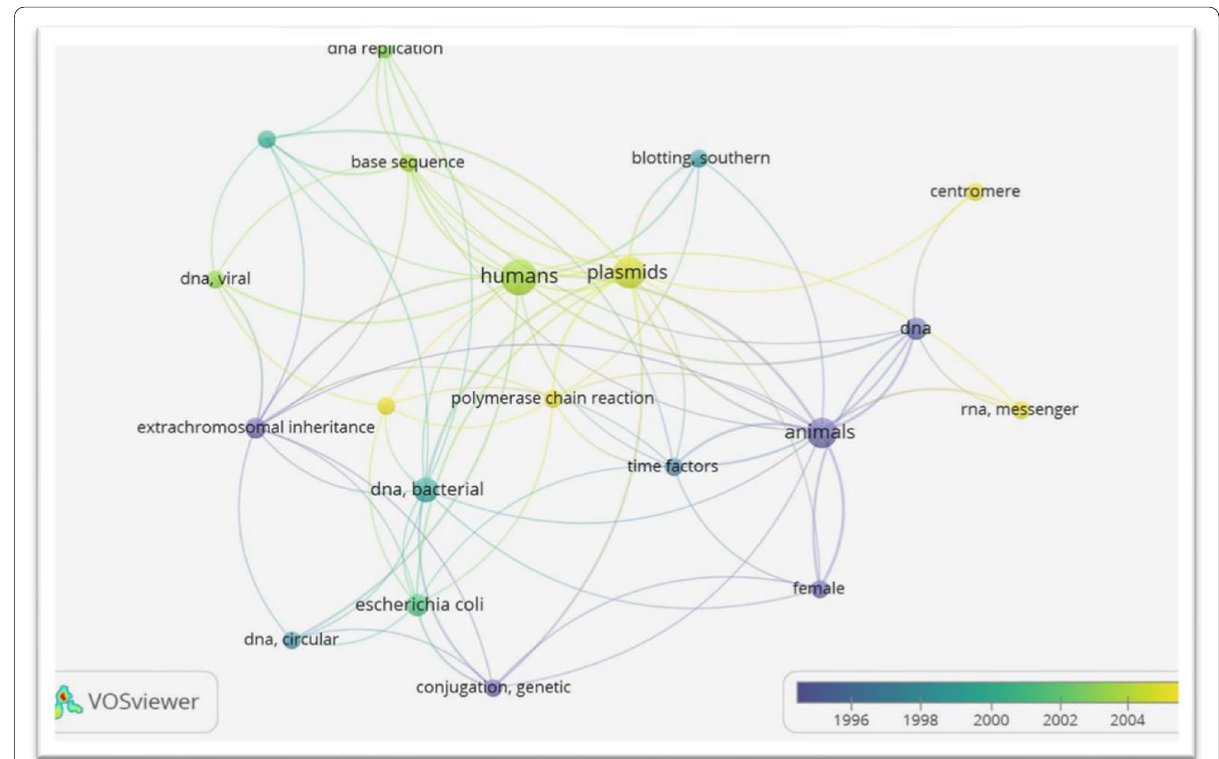
Fig. 3 Analysis of all keywords co-occurrence on full counting by